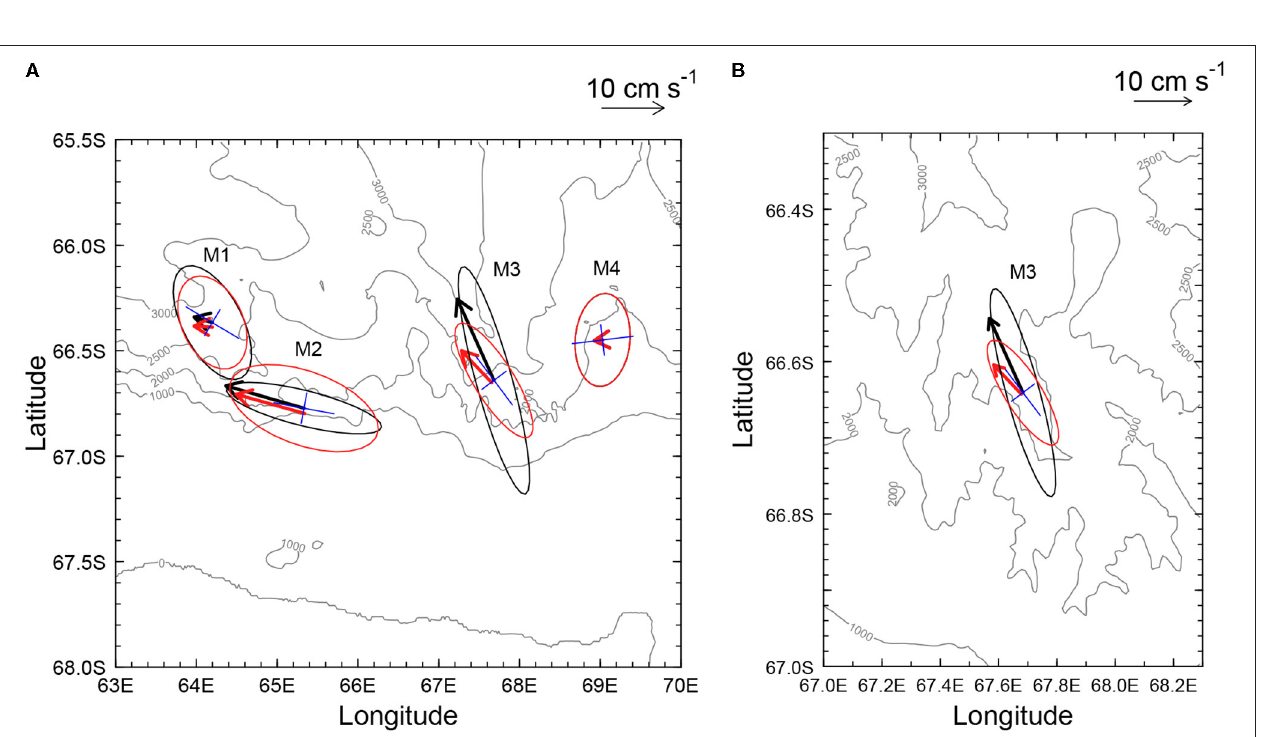
FIGURE 4 | Vectors of the mean velocity and standard deviation ellipses in (A) the entire mooring region and (B) the region around mooring M3. The black vectors and ellipses indicate the mean velocity and standard deviation ellipses for the deepest velocity data. The red vectors and ellipses indicate the mean velocity and standard deviation ellipses for the shallowest velocity data. Contours in (A,B) indicate the isobath based on IBCSO and a shipboard MBES observation, respectively. The bathymetry was not obtained by multi-narrow beam echo sounder (MBES) in part of the region in (B) . In that region, bathymetry was supplemented by the global relief model ETOPO1 (Amante and Eakins, 2009). The long and short blue bars indicate the direction parallel and normal to the isobath, respectively. The direction of the isobath at mooring M3 and other mooring sites was estimated from the bathymetry data based on shipboard MBES observation and IBCSO, respectively.